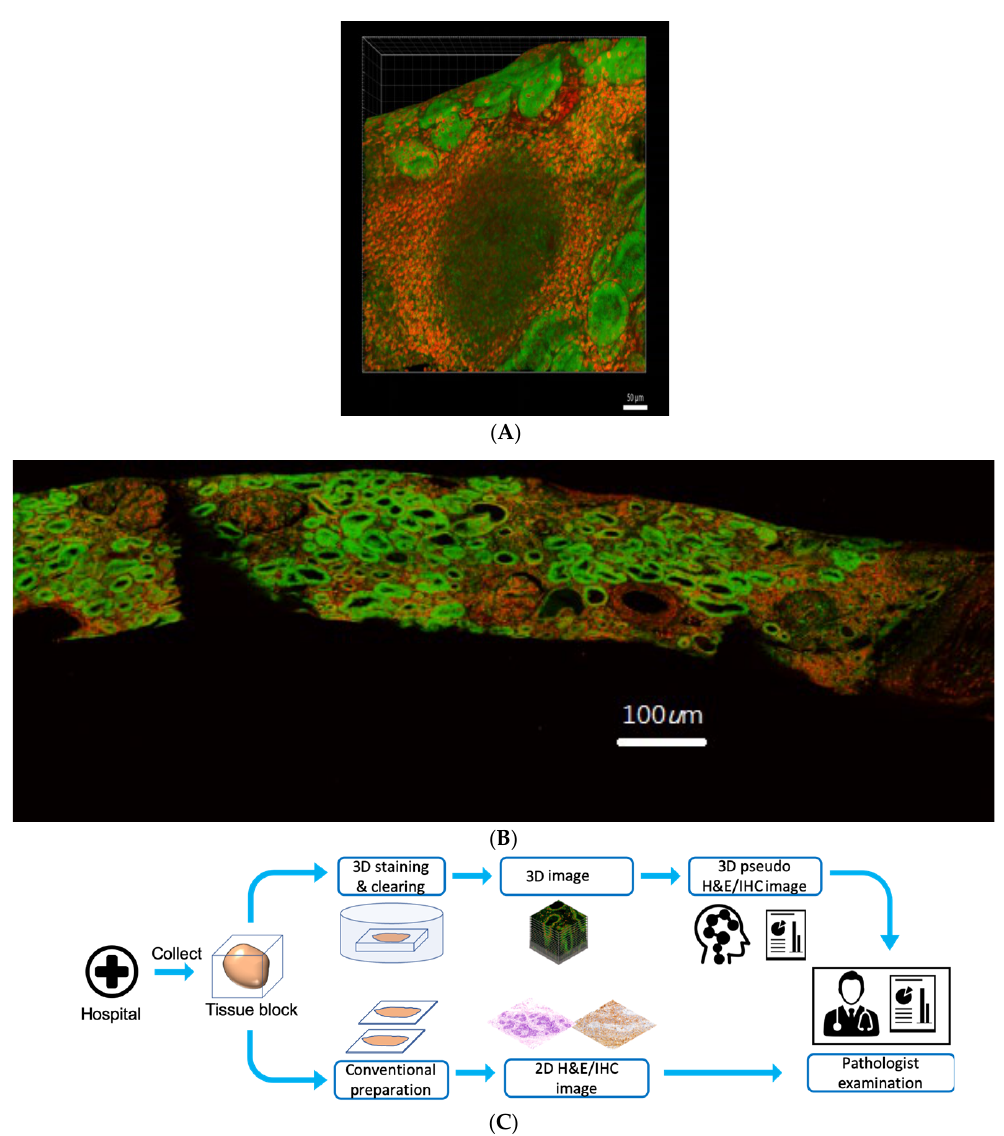
Figure 3. ( A ) 3D image for cell nuclear and membrane of renal tissue. (Cell nuclei were stained as red and membrane as green.). ( B ) Cropped 2D image after “pseudo-needle” track procedure from 3D tissue image. ( C ) Workflow of tissue processing, staining, and final output of the 3D image re- sults.